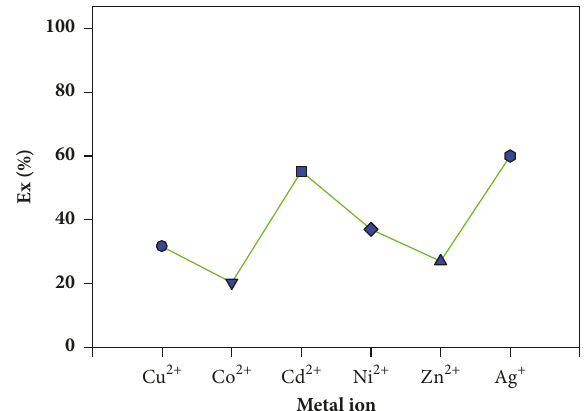
Figure 11: Metal ions percentage extraction (E%) at pH 11.5 by H 8 L- ester. O/A = 1; T = 25 ∘